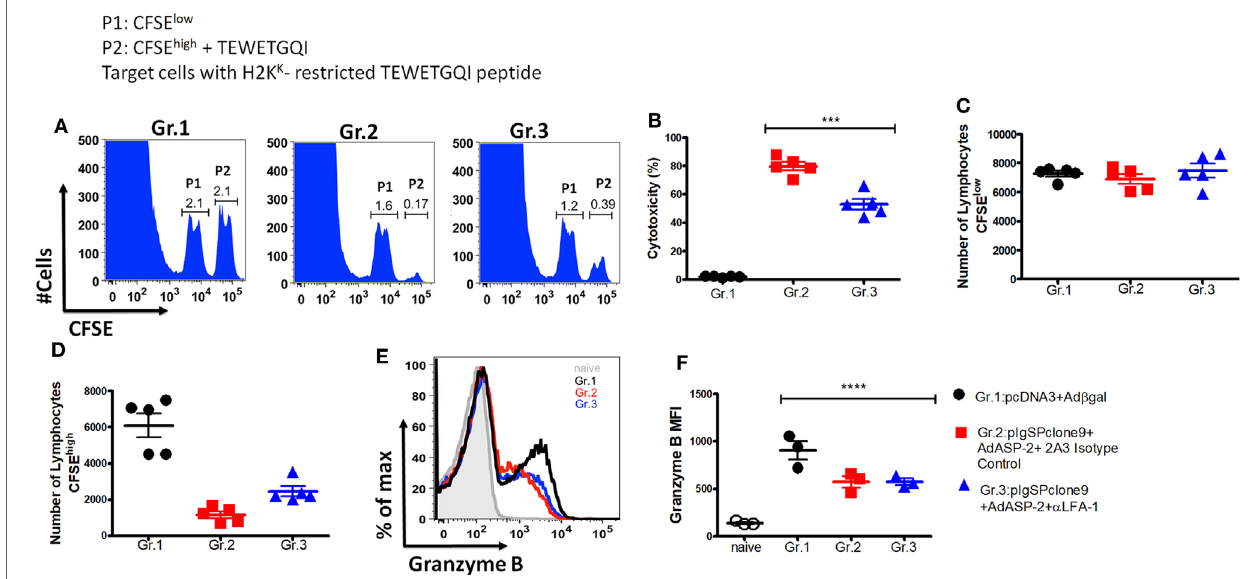
FigUre 7 | Anti-LFA-1 treatment affects the in vivo cytotoxicity of specific CD8 + T cells. A/Sn mice were immunized with ASP-2 using the heterologous “prime- boost” vaccination regimen, infected with 150 trypomastigotes forms of Trypanosoma cruzi , and treated with anti-LFA-1 or isotype control until 20th days after infection. After that, the spleen was harvested for the cytotoxicity assay. Splenocytes from naive mice were used for labeling with CFSE low (1 µM) and CFSE high (10 µM); the CFSE high population was pulsed with the 2.5 µM of peptide TEWETGQI. The mice immunized and anti-LFA-1 treated or untreated received 10 × 10 6 cells from each population via retro-orbital route. In addition, for analysis of granzyme B expression by the specific CD8 + T cells, 2 × 10 6 splenocytes were stimulated in vitro with 10 µM TEWETGQI peptide. After 12 h, the splenocytes were collected for intracellular labeling of granzyme B. (a) The histograms represent the evens of CFSE low (P1) and CFSE high (P2) cells in each group. (B) Percentage of the cytotoxicity of specific CD8 + lymphocytes with the mean ± SD for each individual ( n = 6). (c,D) The graphs with the mean cells CFSE low and CFSE high in the spleen of mice. (e,F) Histograms and the graph represent MFI and the percentage of specific CD8 + T cells that express granzyme B, respectively. The graphs represent the mean ± SD for each individual ( n = 3). Representative results of two independent experiments. Statistical analysis was performed using one-way ANOVA test (*** P < 0.01; **** P =